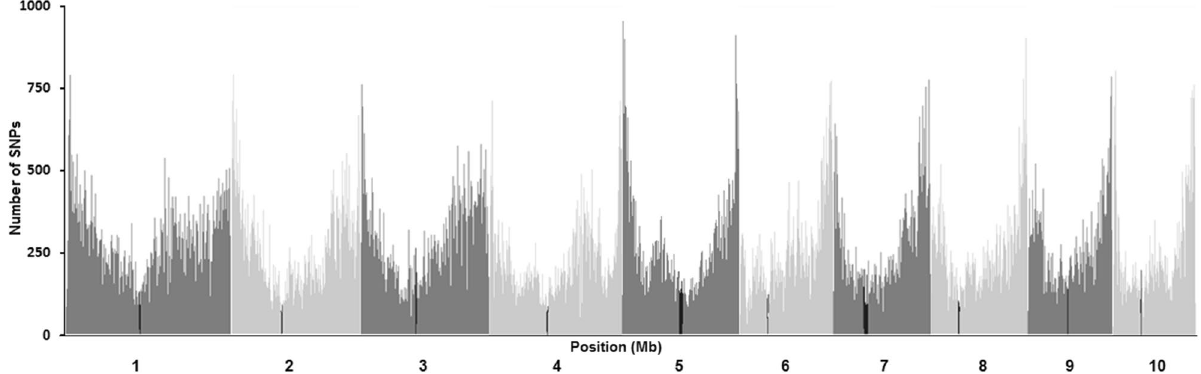
Figure 1. SNP density and distribution pattern on 10 chromosomes of maize genome.